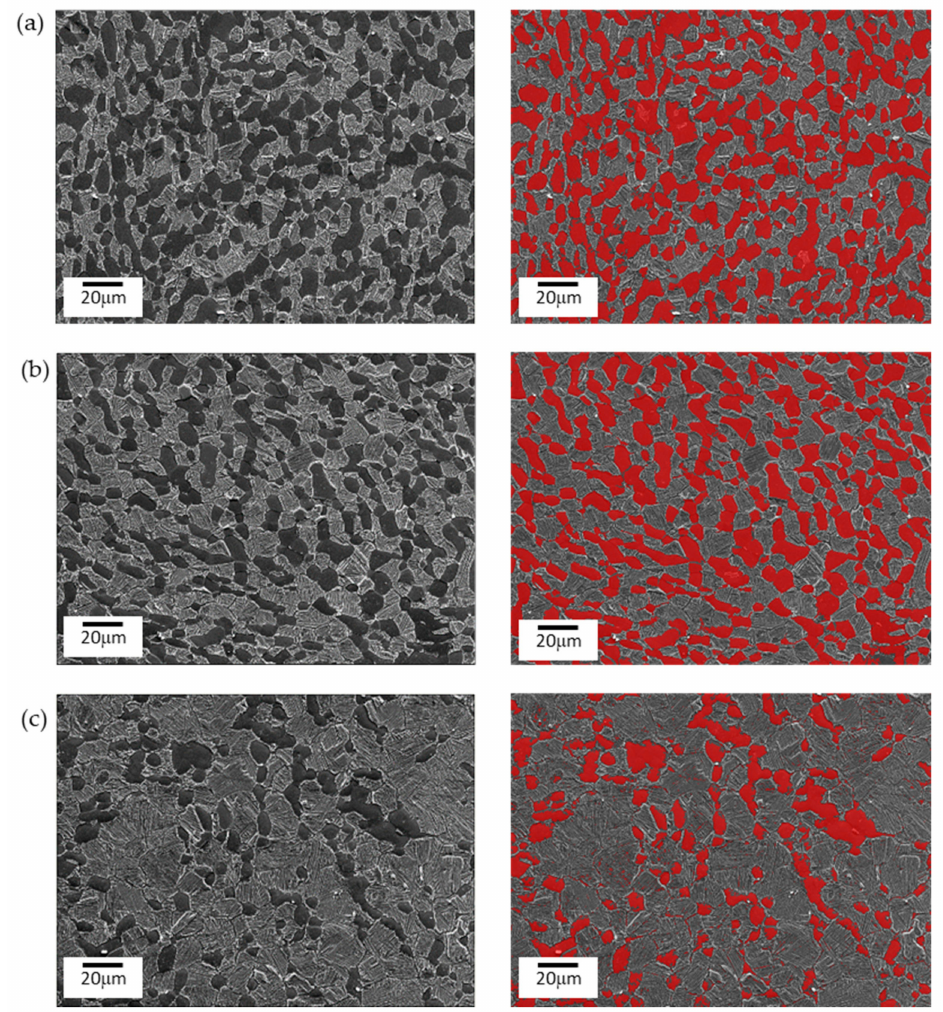
Figure 2. Bi-modal microstructures generated under three solution heat treatment temperatures; ( a ) 820 ◦ C, ( b ) 840 ◦ C, ( c ) 860 ◦ C. Scanning electron microscope imaging ( left ), corresponding image analysis ( right